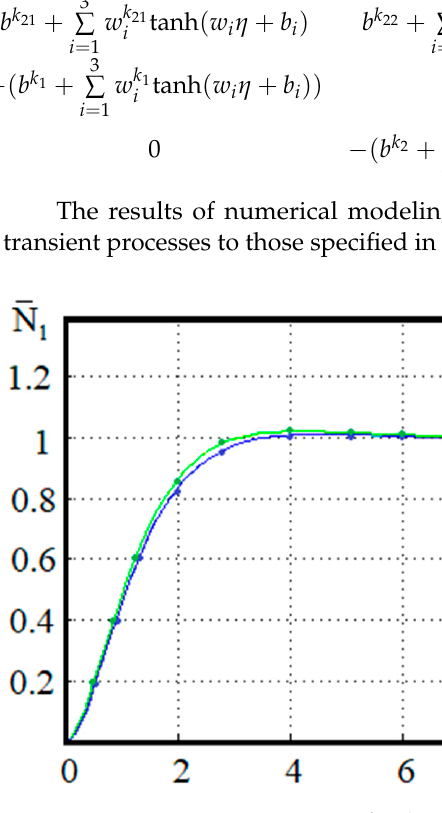
Figure 8. Transient processes curves for the given regime (the blue line represents the given process and the green line represents the simulation results).